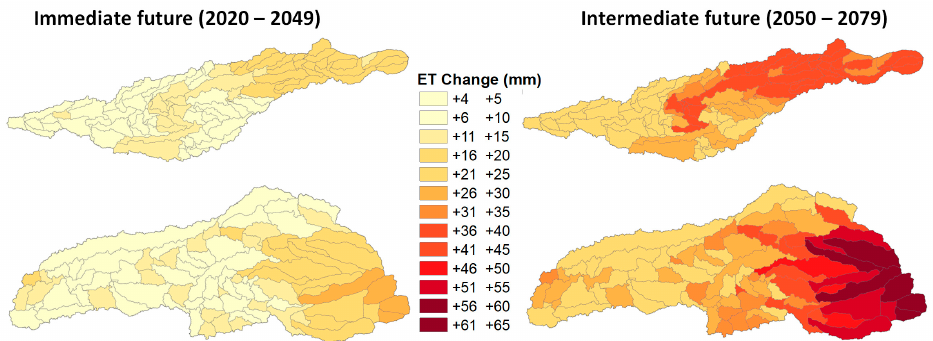
Figure 6. Changes in the yearly average evapotranspiration (ET) at the sub-basin scale, using RegCM4-MPI-ESM-MR, scenario RCP8.5.